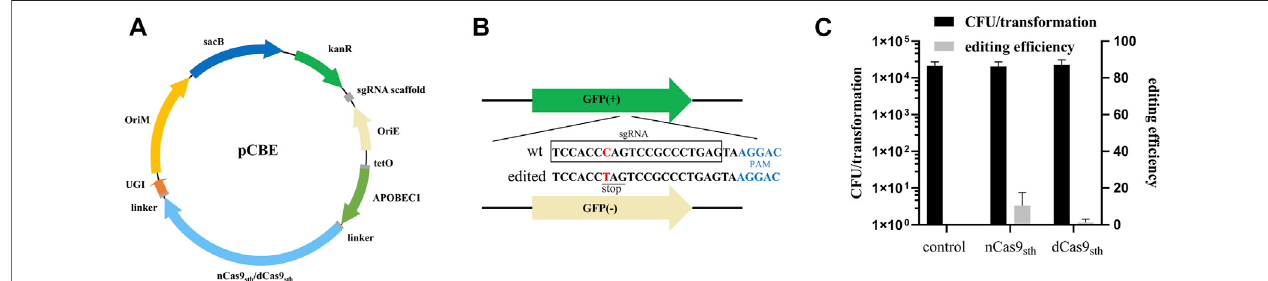
FIGURE1| Cytidinebaseeditingin M.smegmatis . (A) MapofplasmidpCBE.Thesingleeditorplasmidcontains:KanR,kanamycin-resistancemarker;OriE,origin ofreplicationin E.coli ;OriM,originofreplicationinmycobacteria;sgRNAcassette;afusionproteinexpressioncassetteincludingdCas9 sth1 ornCas9 sth1 withAPOBEC1 at the N-terminus and UGI at the C-terminus, under the control of the ATc-inducible P tetO promoter; and the sacB gene for plasmid curing. (B) gfp -targeting sequence. SuccessfuleditingintroducesaTAGstopcodon,resultinginlossofgreen fl uorescence. (C) Colony-formingunits(CFU)pertransformationandeditingef fi ciencyof APOBEC1-nCas9 sth1 /dCas9 sth1 -UGI. Editing ef fi ciency was calculated based on the proportion of GFP-negative colonies. Results are the average of at least two independent experiments, and error bars depict the standard